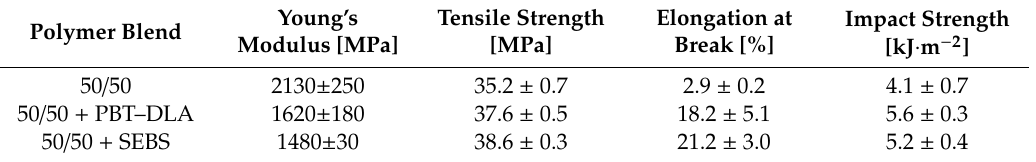
Table 6. Mechanical properties of 50 / 50 PP / PBT blends (mean ± SD, n =